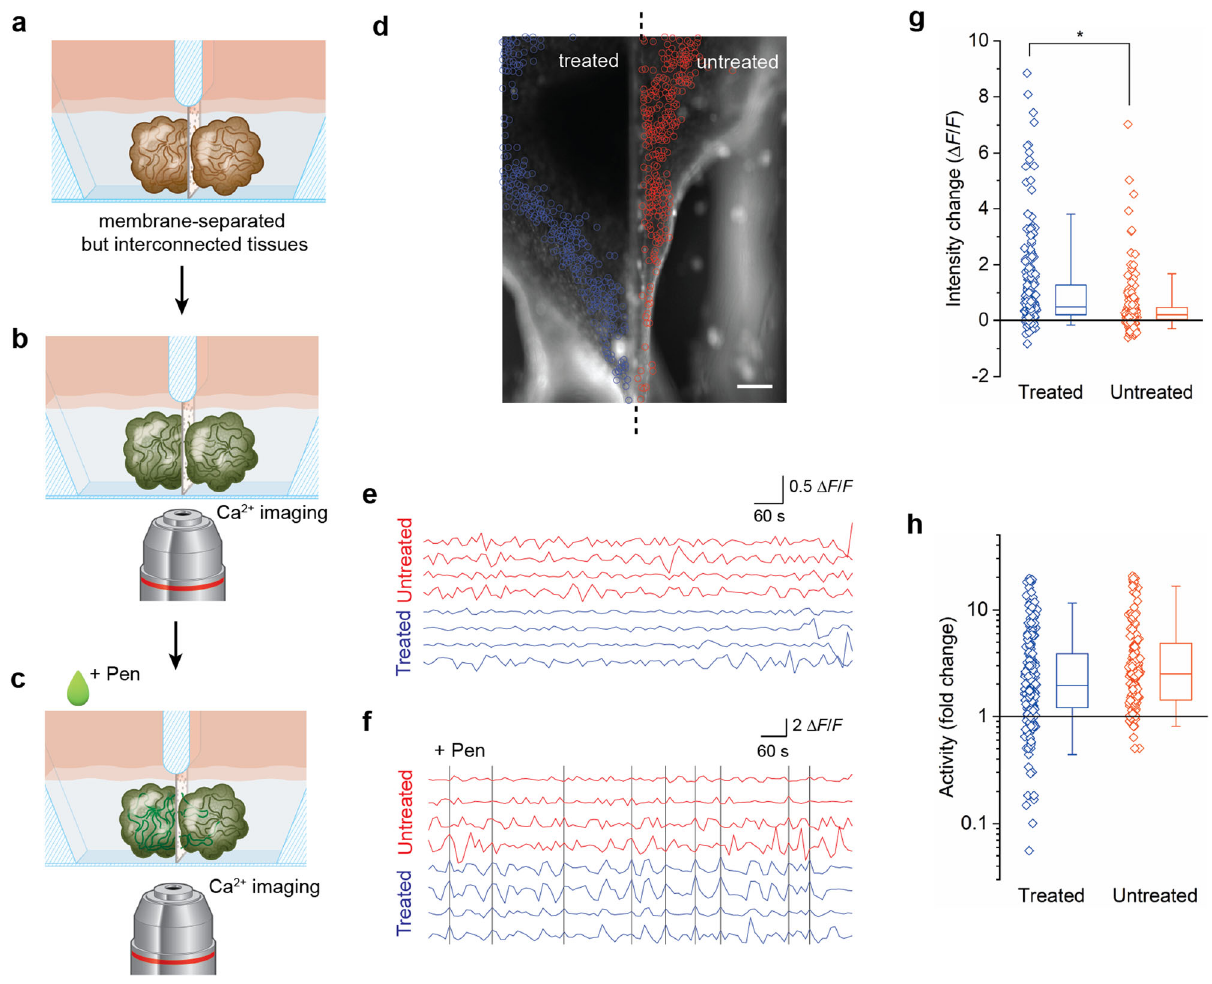
Fig. 3 Signal propagation between interconnected cerebral tissues. a – c Schematics indicating the steps involved in the Penicillin-treatment experiments. Two cerebral tissues were generated in the two chambers of the PDMS-based iS3CC chip (see also Supplementary Fig. 2 for more details of the chip) and formed a connection through the porous membrane ( a , see also Supplementary Fig. 3). To study the propagation of abnormal discharges from one tissue to the other, calcium imaging was performed on both tissues ( b ) and Penicillin G ( “ Pen ” ) was added to one of the chambers ( c ). d Fluorescence pictures of intracellular calcium detected by fl uo-4 direct in cerebral tissues at day 45 where one of the chambers (left, “ treated ” ) was treated with Penicillin G, whereas the other (right, “ untreated ” ) was not. The activity of 522 neurons was detected in the treated (blue circles) and untreated (red circles) tissues and analyzed by live calcium imaging (see also Supplementary Movie 3). Scale bar: 250 µ m ( n = 6 samples across six independent experiments). e , f Time traces of four selected cells in the treated (blue) and untreated (red) cerebral tissues pre- ( e ) and post-treatment ( f ) with Penicillin G (see also Supplementary Fig. 4). The black vertical lines indicate instances where all four cells in the treated tissue showed synchronized transient peaks. This synchronicity propagated ~45% of the time to the cells in the untreated tissue. g , h Quanti fi cation of the change in fl uorescence intensity ( g ) and fold change in neuronal activity ( h , log scale) induced by the addition of Penicillin G in the treated (blue) and untreated (red) cerebral tissues. The symbols represent data for each cell; the boxes represent the median, fi rst, and third quartiles; and the whiskers represent the fi fth and 95th percentiles of the population data. Asterisk denotes statistically signi fi cant difference (Mann – Whitney U -test, p < 10 − 11